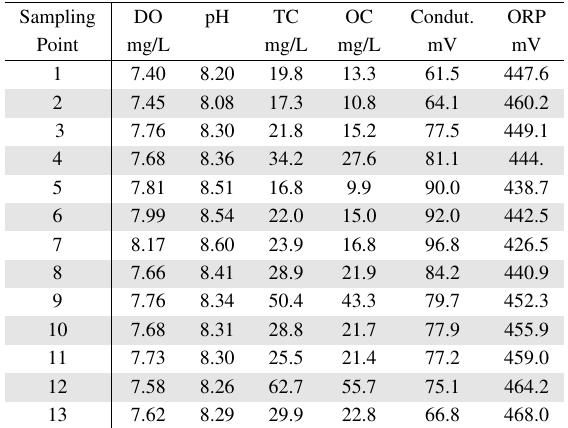
Table 3. Values obtained for the four non optically active component parameters.